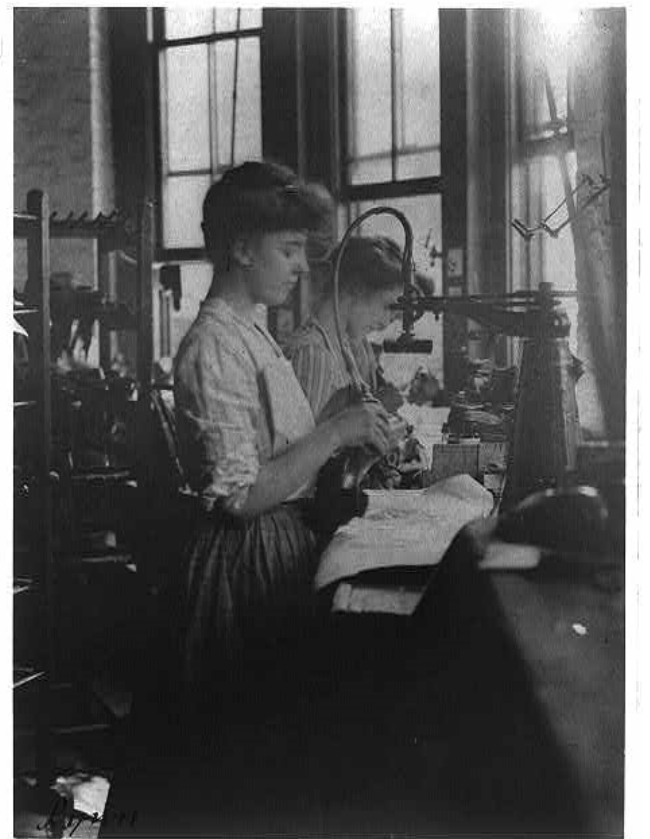
Figure 24. Frances Benjamin Johnston. 1895. Two women working in shoe factory, Lynn, M.A. Library of Congress.